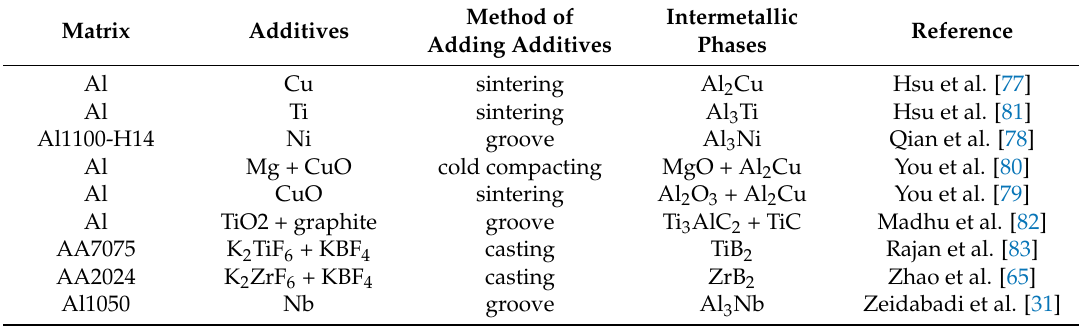
Table 3. In situ composites fabricated via